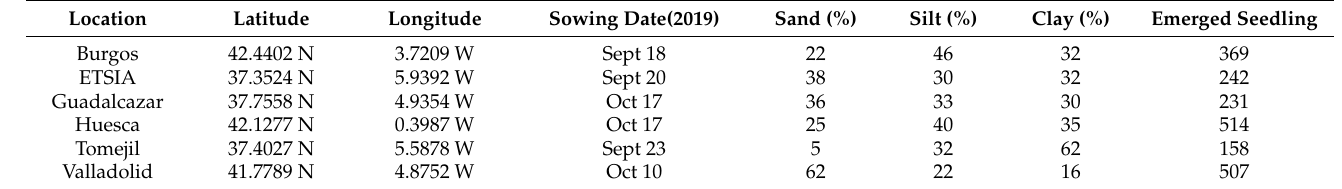
Table 3. Additional P. paradoxa experiments. Location, soil texture and total emerged seedling. Location